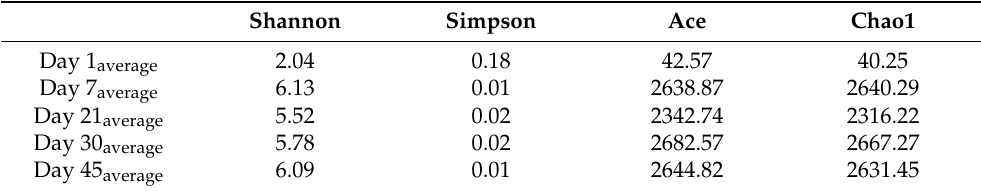
Table 1. Species’ richness and diversity indicators of the microbial communities of samples.